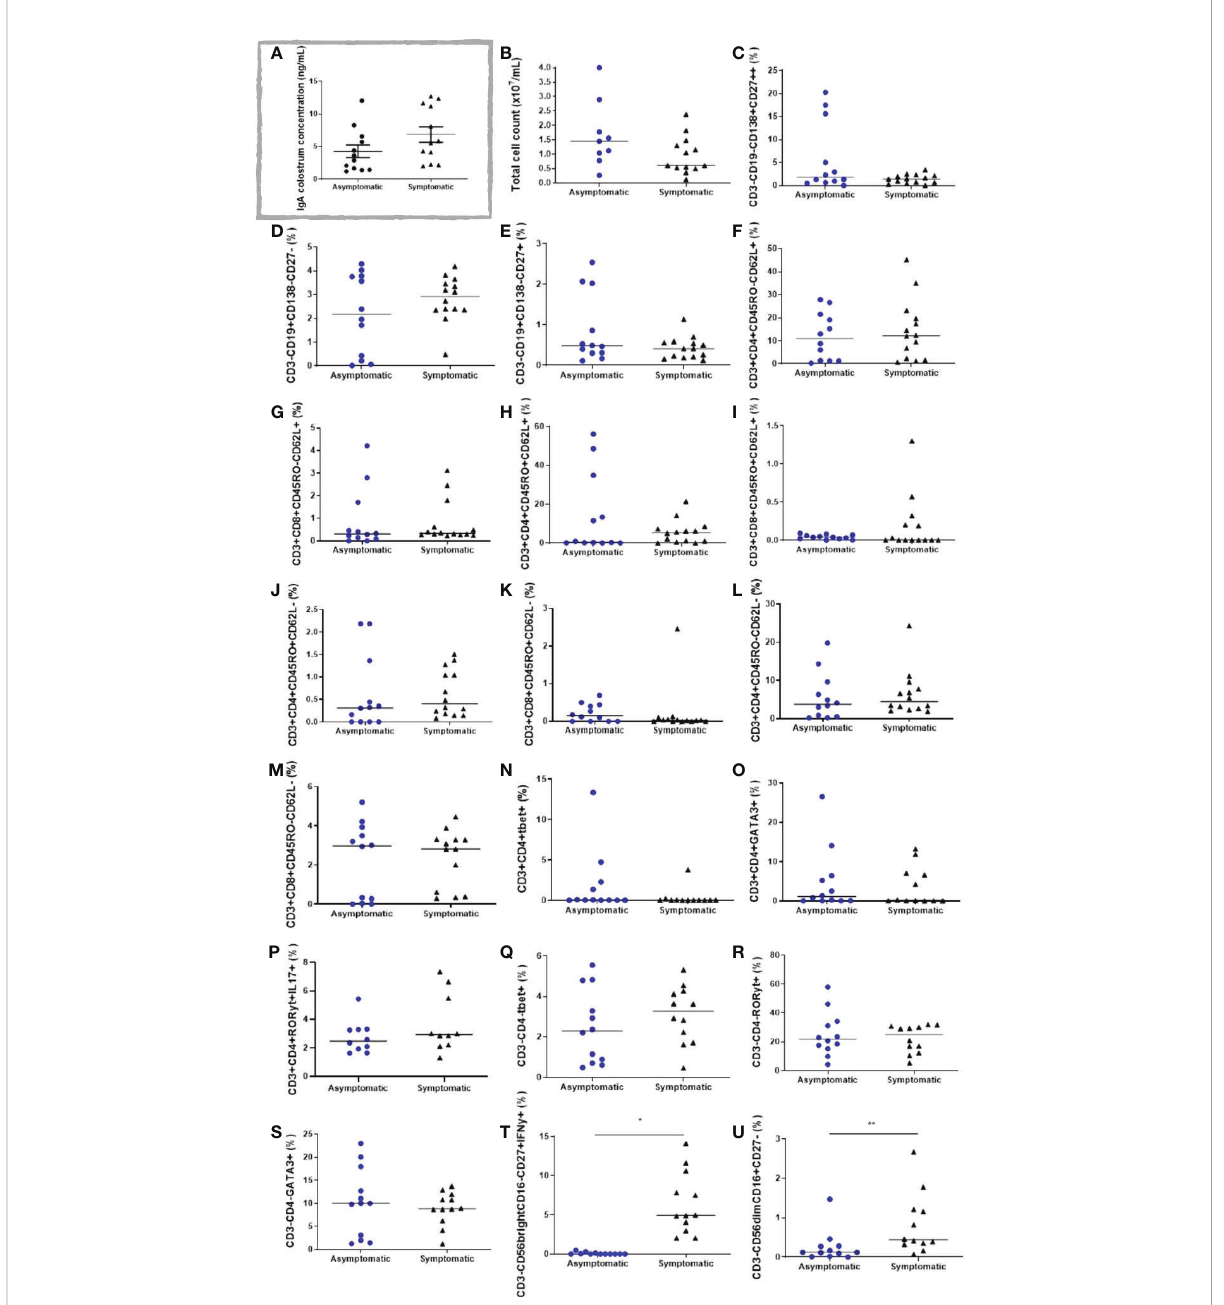
FIGURE 4 Cell populations in the colostrum of symptomatic (n=14) and asymptomatic (n=12) for Covid-19 of lactating women, during pregnancy. (A) IgA colostrum concentration (ng mL -1 ). (B) Total cell count (x10 7 mL -1 ). (C) Percentage of cells CD3-CD19 - CD138 + CD27 ++ . (D) Percentage of cells CD3 - CD19 + CD138 - CD27 - . (E) Percentage of cells CD3 - CD19 + CD138 - CD27 + . (F) Percentage of cells CD3 + CD4 + CD45RO - CD62L + . (G) Percentage of cells CD3 + CD8 + CD45RO - CD62L + . (H) Percentage of cells CD3 + CD4 + CD45RO + CD62L + . (I) Percentage of cells D3 + CD8 + CD45RO + CD62L + . (J) Percentage of cells CD3 + CD4 + CD45RO + CD62L - . (L) Percentage of cells CD3 + CD8 + CD45RO + CD62L - . (K) Percentage of cells CD3 + CD4 + CD45RO - CD62L - . (M) Percentage of cells CD3 + CD8 + CD45RO - CD62L - . (N) Percentage of cells CD3 + CD4 + Tbet + . (O) Percentage of cells CD3 + CD4 + GATA3 + . (P) Percentage of cells CD3 + CD4 + ROR g t + IL17A + . (Q) Percentage of cells CD3 - CD4 - Tbet + . (R) Percentage of cells CD3 - CD4 - ROR g t + . (S) Percentage of cells CD3 - CD4 - GATA3 + . (T) Percentage of cells CD3 - CD56 bright CD16 - CD27 + IFN- g + . (U) Percentage of cells CD3 - CD56 dim CD16 + CD27 - . Data are presented as median and 95% CI. Mann – Whitney test: p < 0.05. * p < 0.000. ** p =